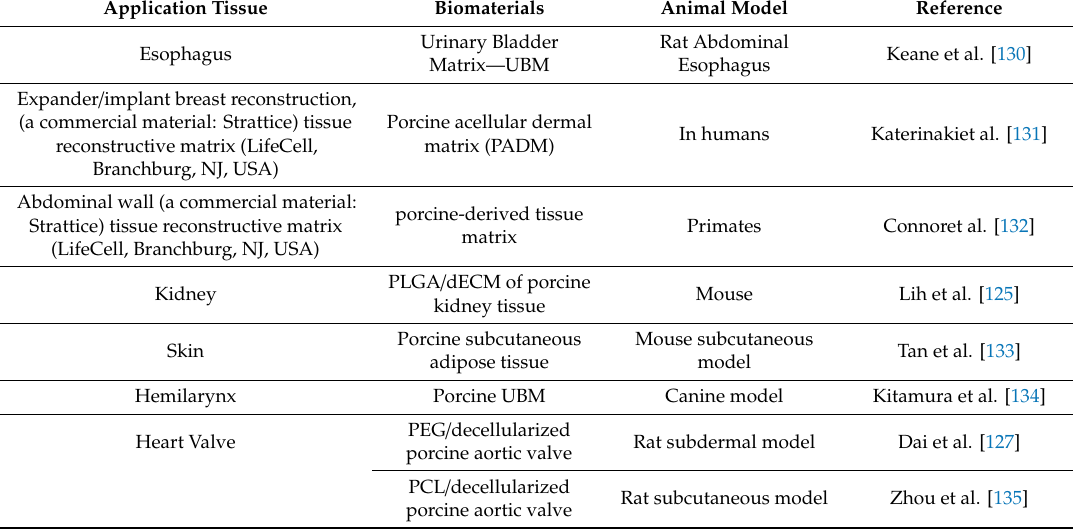
Table 4. Examples of decellularized extracellular matrix (dECM)-based sca ff olds for in situ tissue regeneration Application